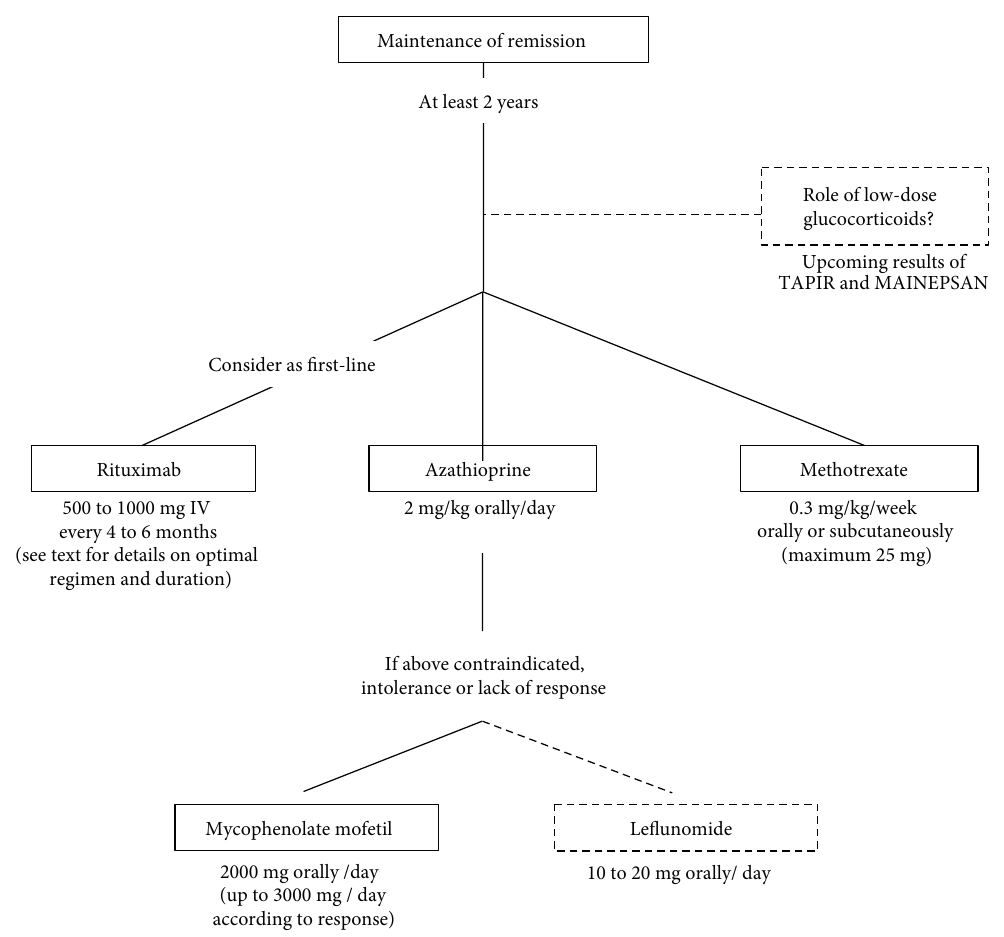
Figure 3: Suggested algorithm of maintenance therapy in severe GPA and